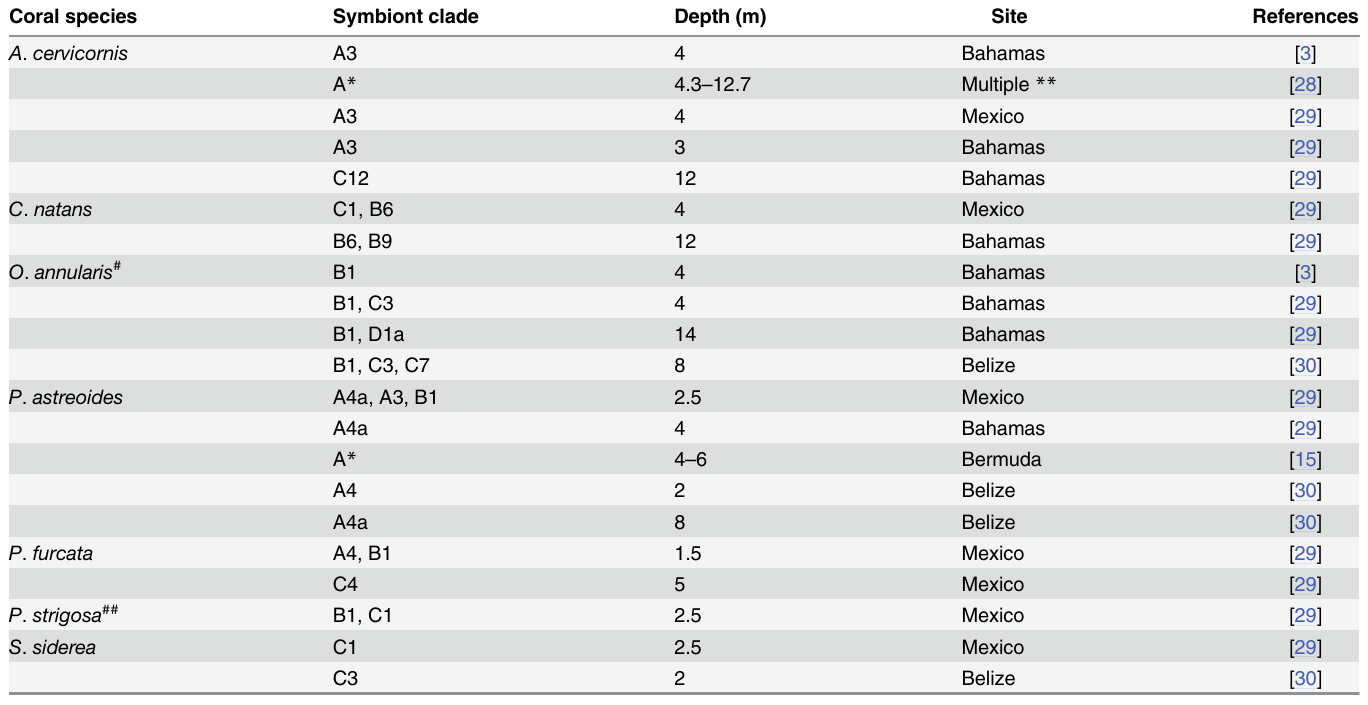
Table 1. Summary of symbiont clades found in the literature for the seven coral species sampled during the present study. Coral